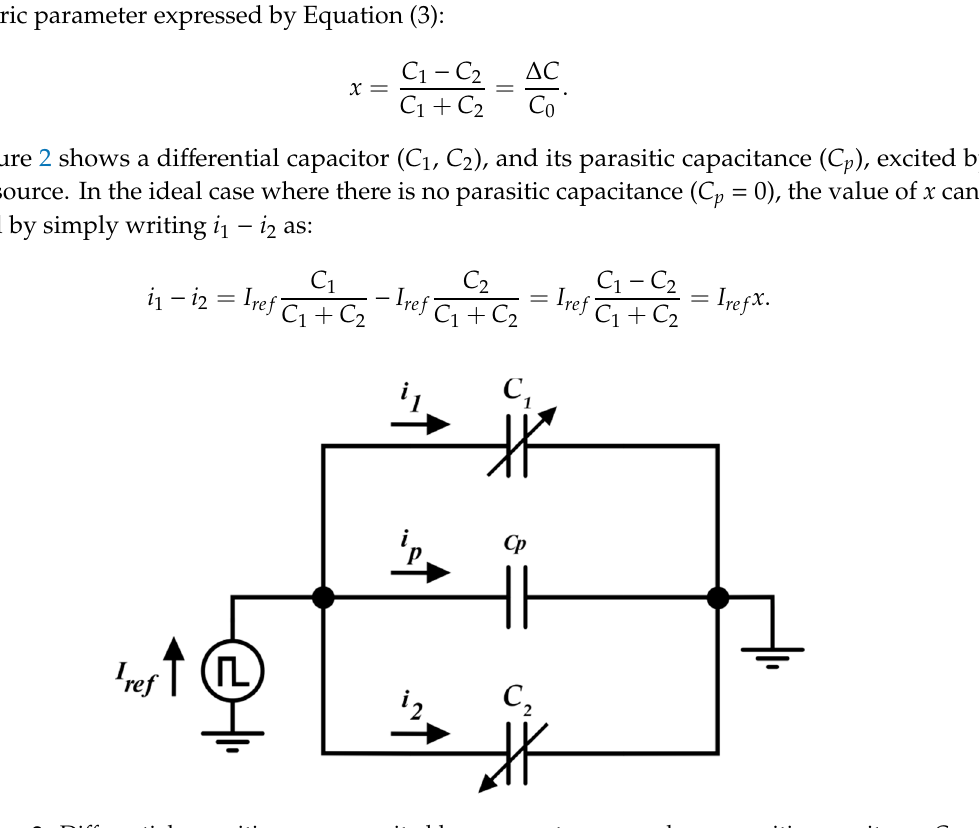
Figure 1. Differential capacitive sensor ( a ) schematic and structure when the measurand influences ( b ) the overlapping area of plates; ( c ) the distance between plates. Figure 2. Differential capacitive sensor excited by a current source, where parasitic capacitance C p is evidenced.